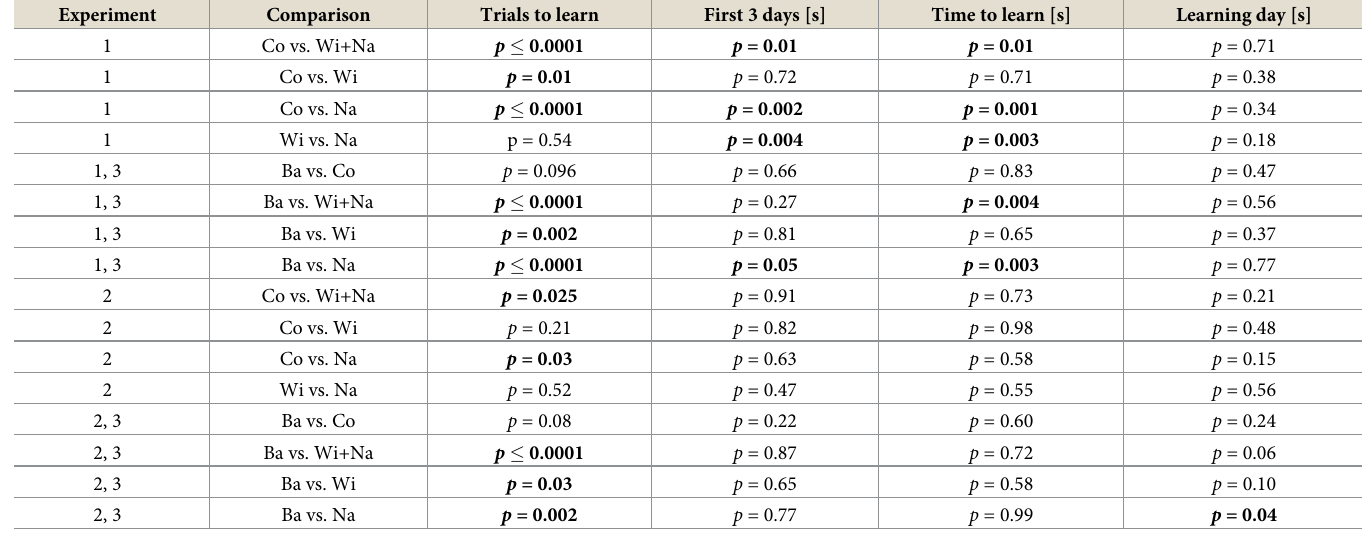
Table 1. Results of Experiment 1, 2, and 3: Re´sume´. The table summarizes the main results ( p -values) for the four variables measured in Experiments 1, 2, and 3, with respect to the following comparisons: Congruence vs. wide + narrow-incongruence (Co vs. Wi+Na); congruence vs. wide-incongruence (Co vs. Wi); congruence vs. nar- row-Incongruence (Co vs. Na); wide-incongruence vs. narrow-incongruence (Wi vs. Na); baseline vs. congruence (Ba vs. Co); baseline vs. wide + narrow-incongruence (Ba vs. Wi+Na); baseline vs. wide-incongruence (Ba vs. Wi); baseline vs. narrow-incongruence (Ba vs.